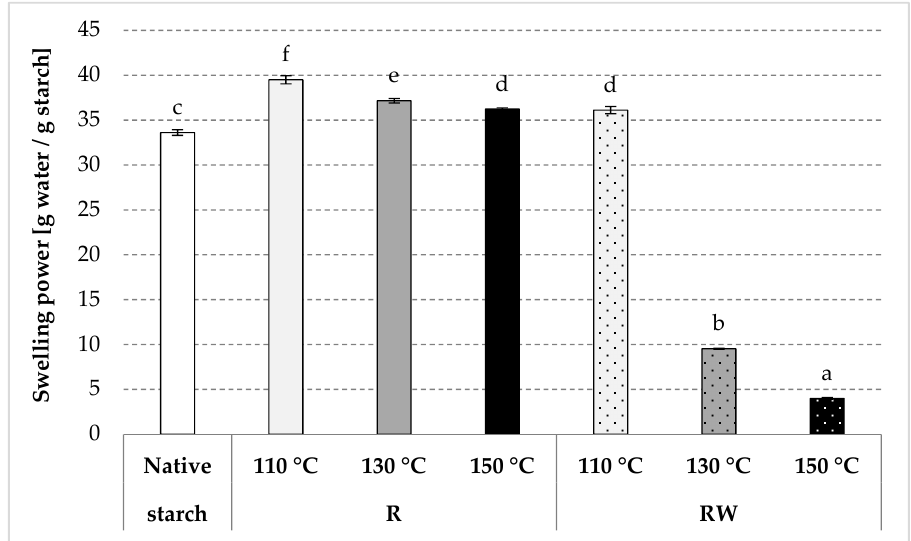
Figure 4. Swelling power determined in the native modified starch preparations. The results are expressed as the mean ± SD ( n = 3). Different letters above the bars indicate that the values are significantly different at p < 0.05. R—roasted starch without wastewater; RW—roasted starch with wastewater.